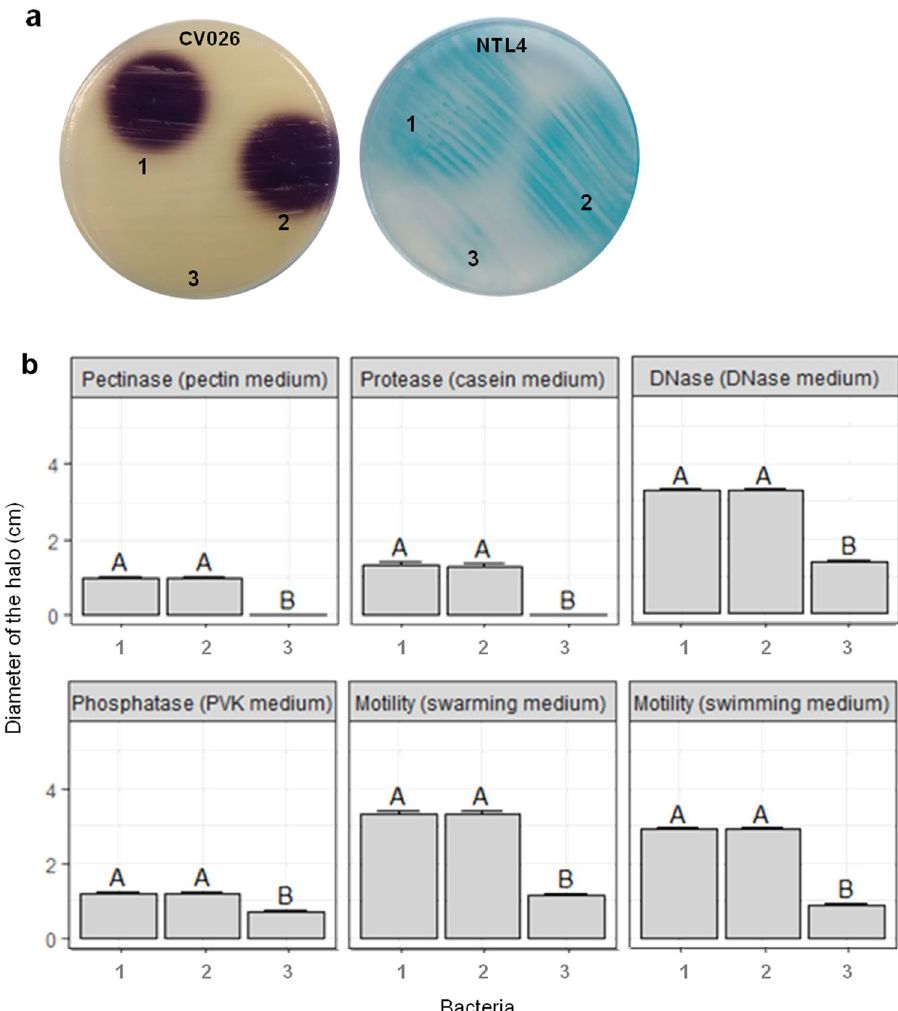
Figure 6. Quorum quenching of AHLs and QS-regulated functions in Pectobacterium carotovorum . ( a ) AHL detection using the biosensors Chromobacterium violaceum CV026 and Agrobacterium tumefaciens NTL4 (pZRL4). ( b ) Phenotypes tested in pectin, casein, DNase, PVK (alkaline phosphatase), swarming and swimming media. Error bars represent standard deviations. For each assay, the P . carotovorum strain without plasmid (1), with the empty plasmid (pME6010) (2) and the plasmid carrying hqiA (3) were compared. For the bioassays presented in panel b, different letters above the bars indicate that the values are significantly different according to a one-factor (treatment) ANOVA (P < 0.05) and the Tukey